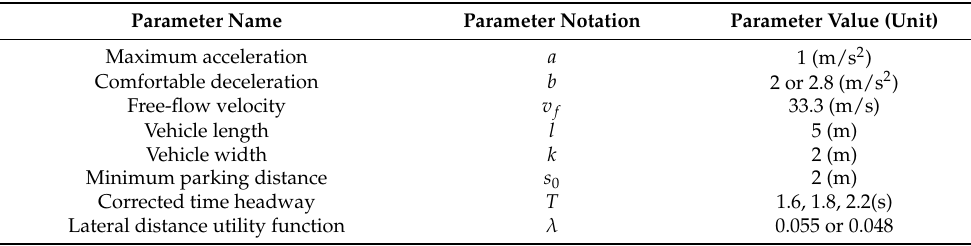
Table 3. Parameter